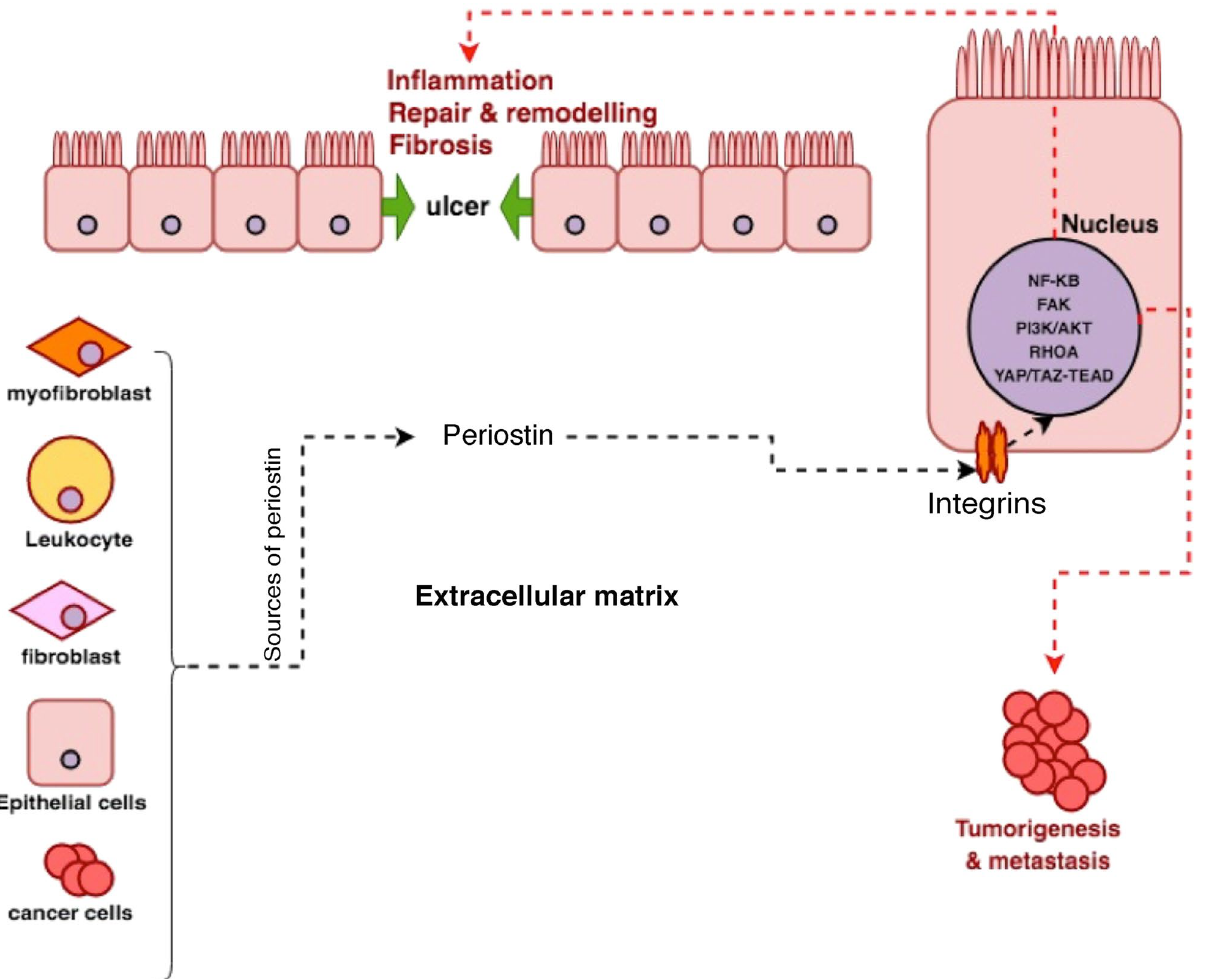
Figure 6. Pathophysiology of periostin. In the tissue, periostin is primarily produced by the fibroblasts and myofibroblasts. It has also been detected in tumour cells, epithelial cells and leukocytes. After engaging with the αv-integrin receptors within the cell membrane, periostin facilitates transmission of signals for cellular adhesion and activation of various immune-signalling pathways. These include the focal adhesion kinase (FAK) phosphatidylinositol 3-kinase (PI3K)/AKT, NF-κB, and RHOA and YAP/TAZ TEAD signalling pathways. These pathways further fuel inflammation and also contribute to tissue repair and remodelling as well as fibrosis and tumorigenesis. This figure was generated by TC using the software https ://app.diagr ams.net. (Abbreviations: TAZ, transcriptional co-activator with PDZ-binding motif; TEAD, TEA domain family member 1; YAP, Yes- associated